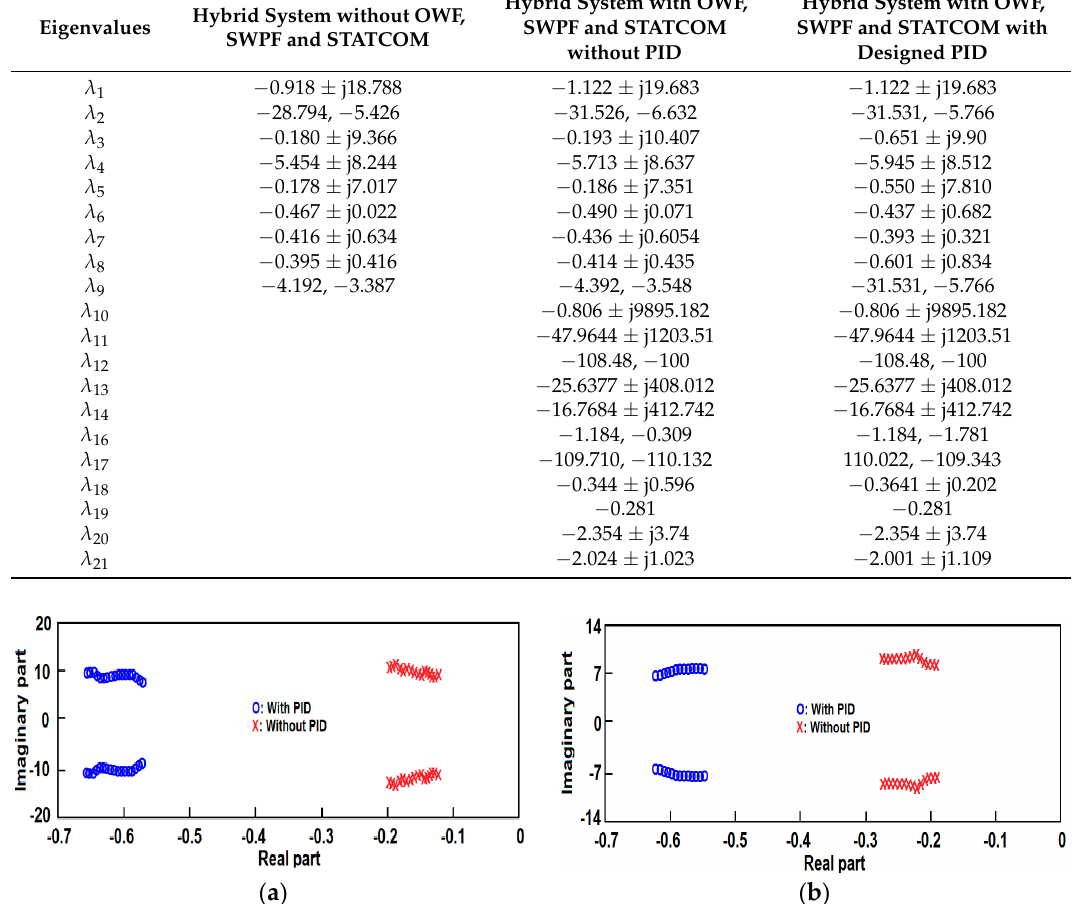
Figure 4. The results of root locus for the eigenvalues ( a ) the rotor angle δ S ; ( b ) the rotor angle δ M .